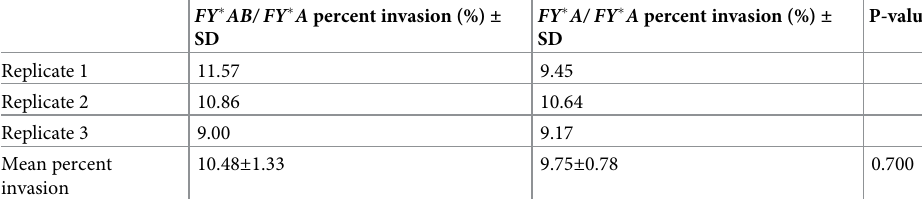
Table 4. Comparison of invasion percentage between the Duffy FY � AB and FY � A blood